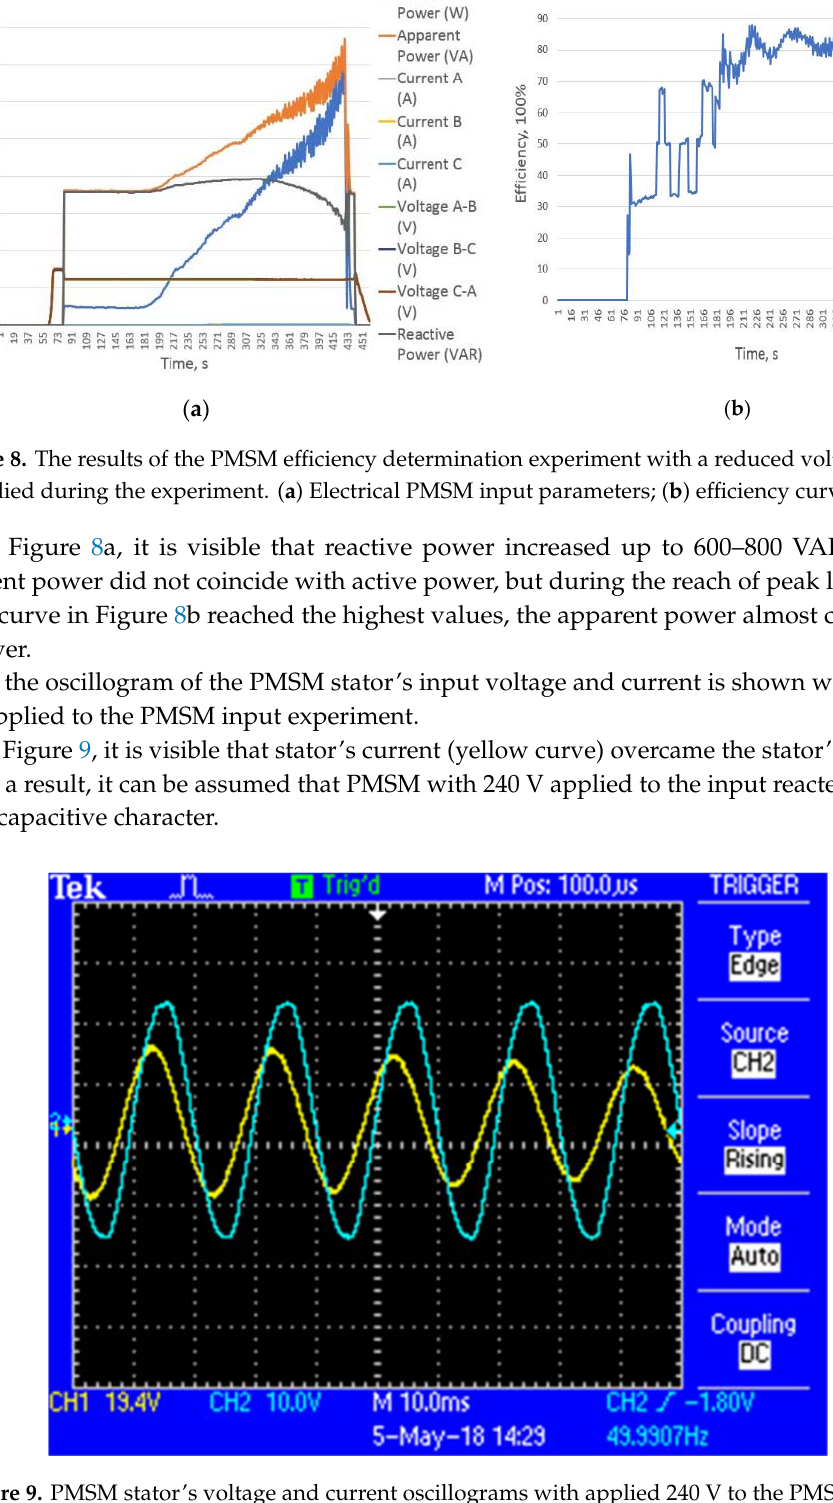
Figure 9. PMSM stator’s voltage and current oscillograms with applied 240 V to the PMSM